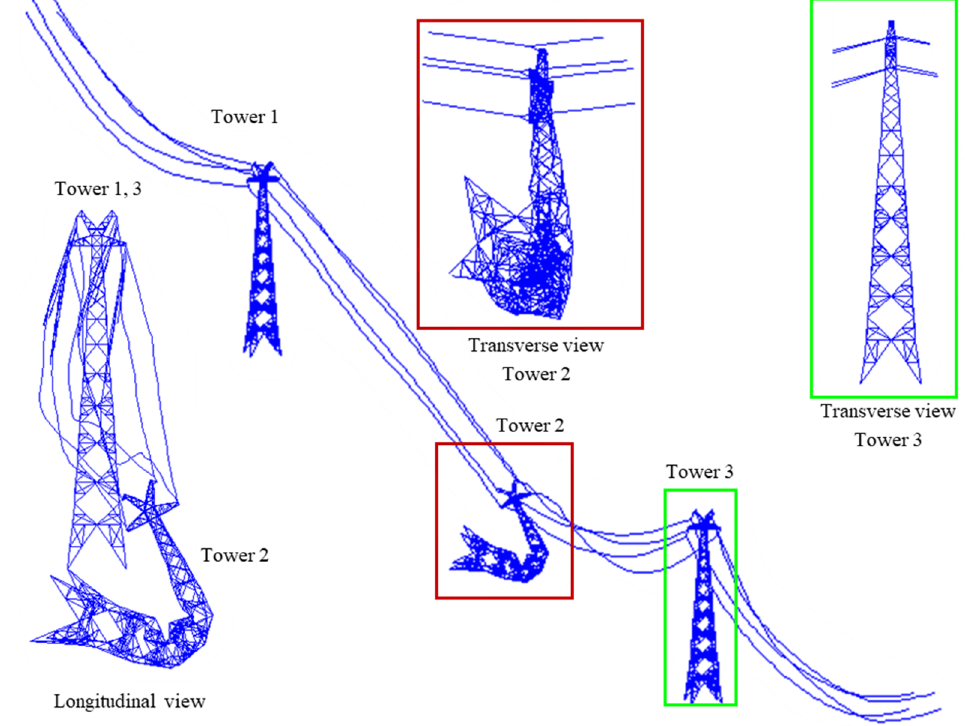
Figure 17. Behavior of the transmission tower-line structure at t = 13 s under Case 2.